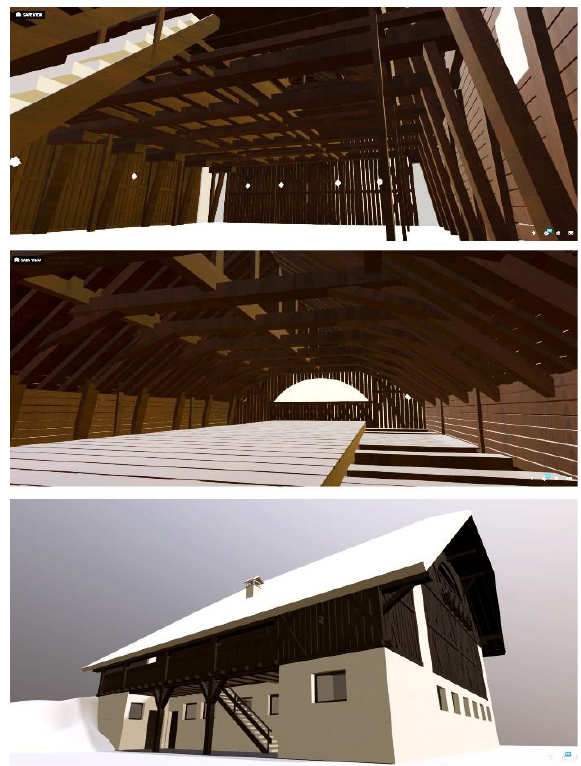
Figure 3: VR internal and external images of the Aschnerhof